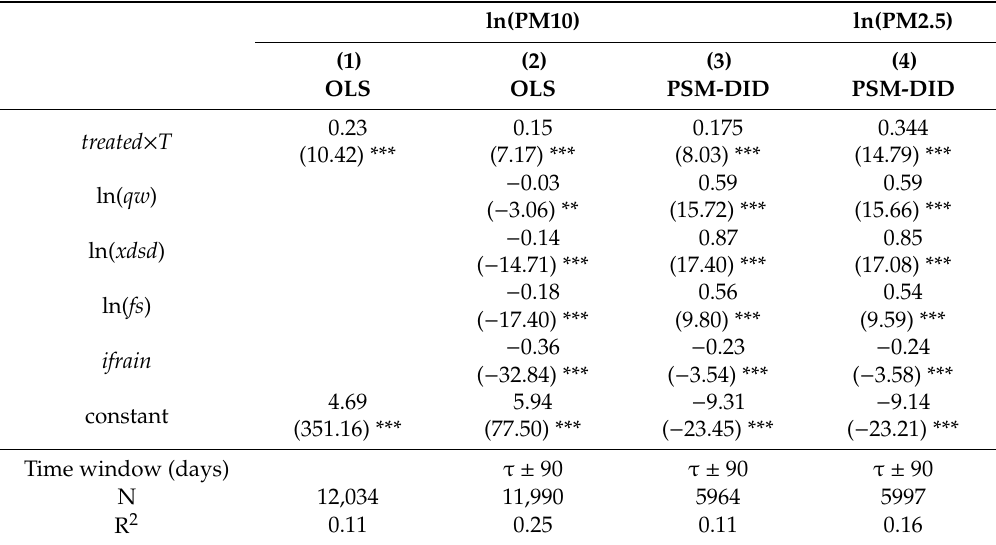
Table 5. OLS, DID and PSM-DID estimates with a fixed time window (i.e., 90 days).